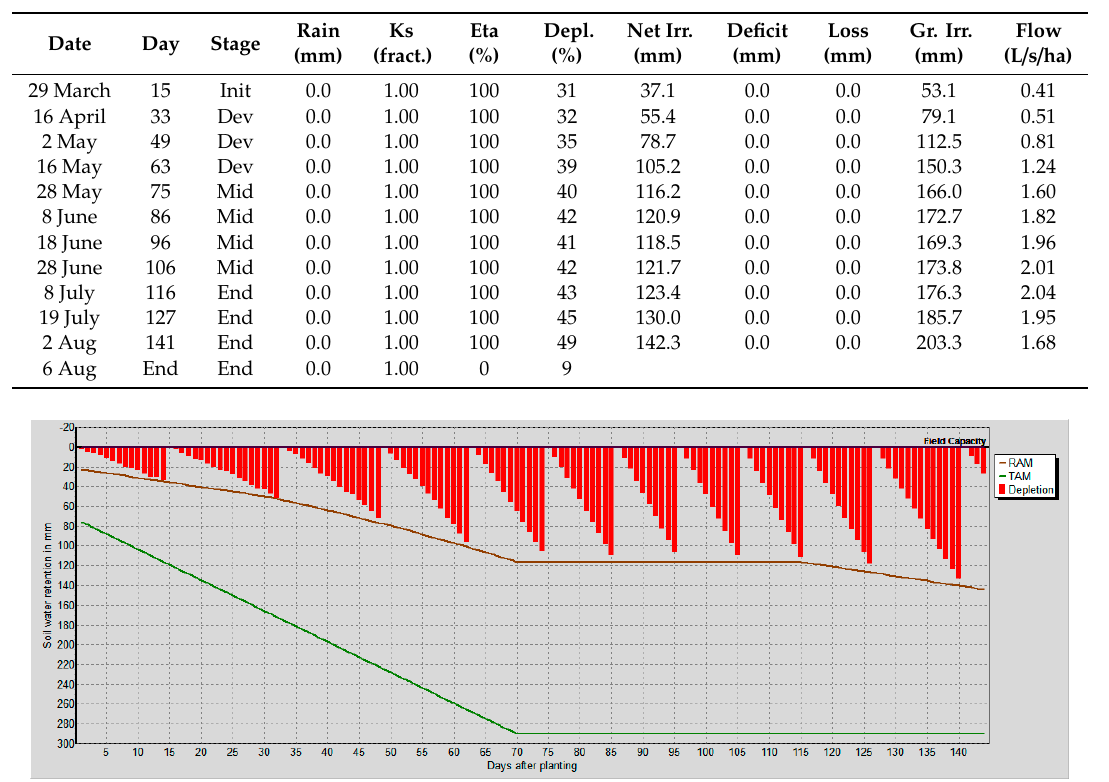
Figure 5. Irrigation schedules for tomatoes.